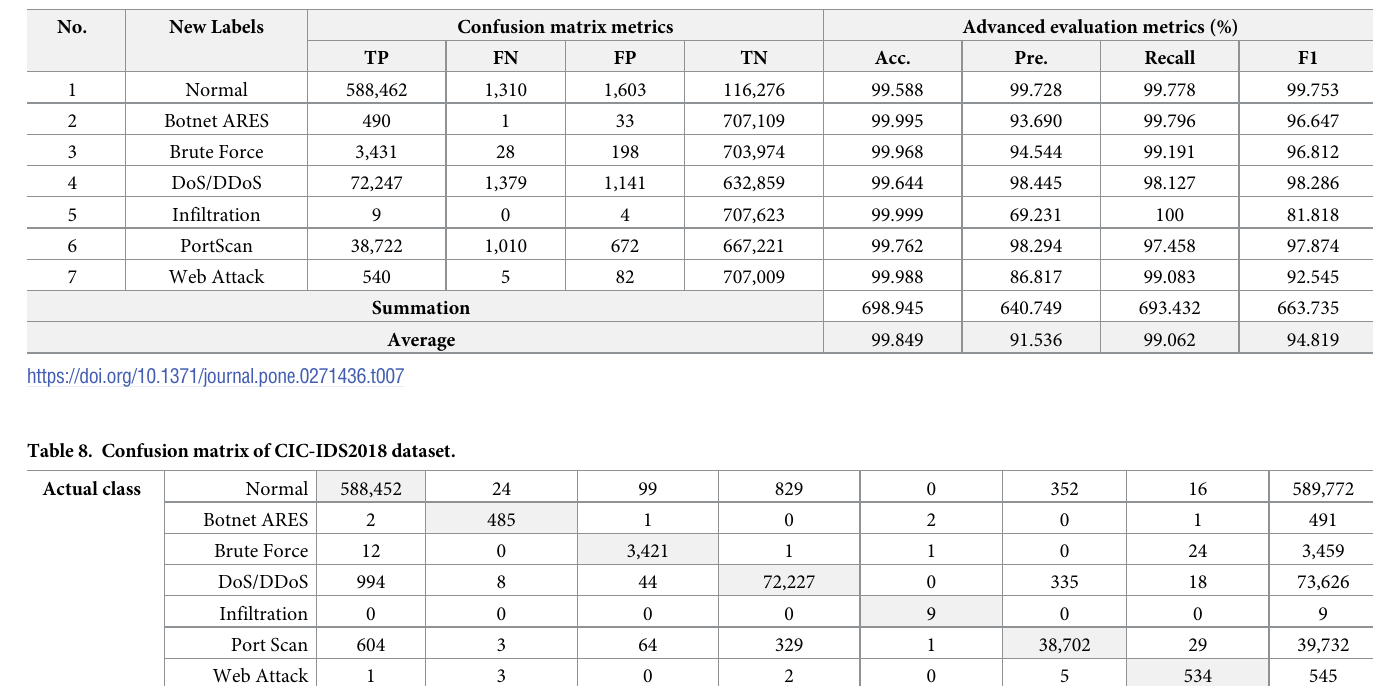
Table 7. CIC-IDS2018 metrics of the above confusion matrix.